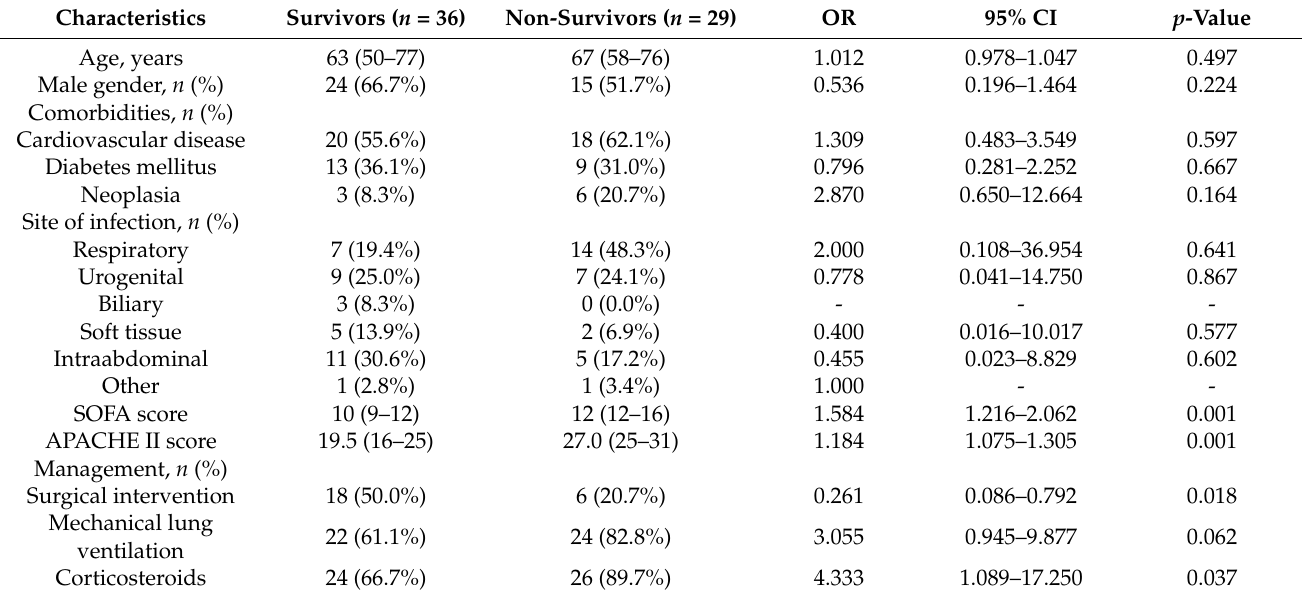
Table 1. Univariable comparison of general characteristics between the two patient groups.